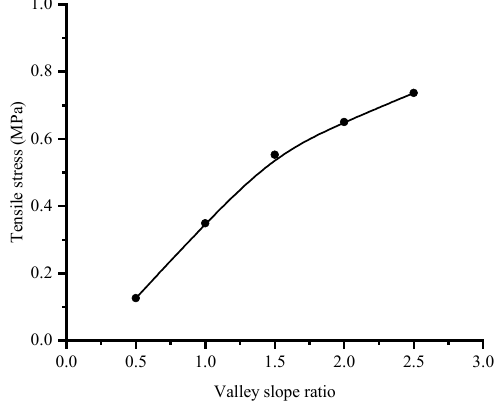
Appl. Sci. 2019 , 9 , x FOR PEER REVIEW Figure 24. Relationship between tensile stress maximum of SACC and valley slope ratio.